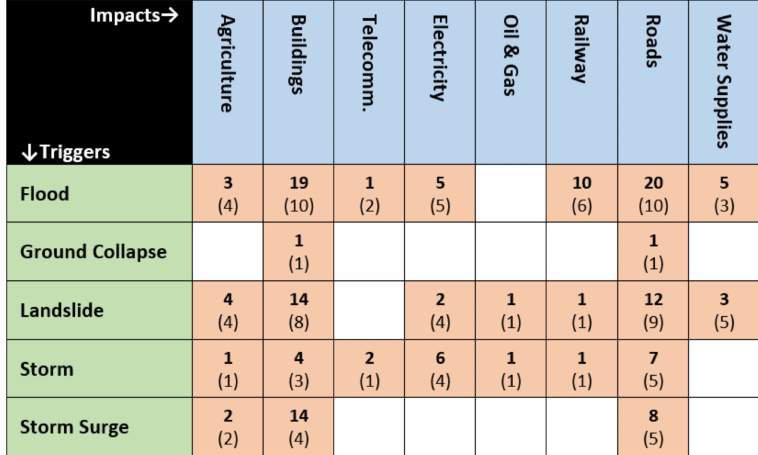
Figure 4. Matrix of natural hazard triggers and infrastructural impacts showing the number of cases in bold and the number of mechanisms in